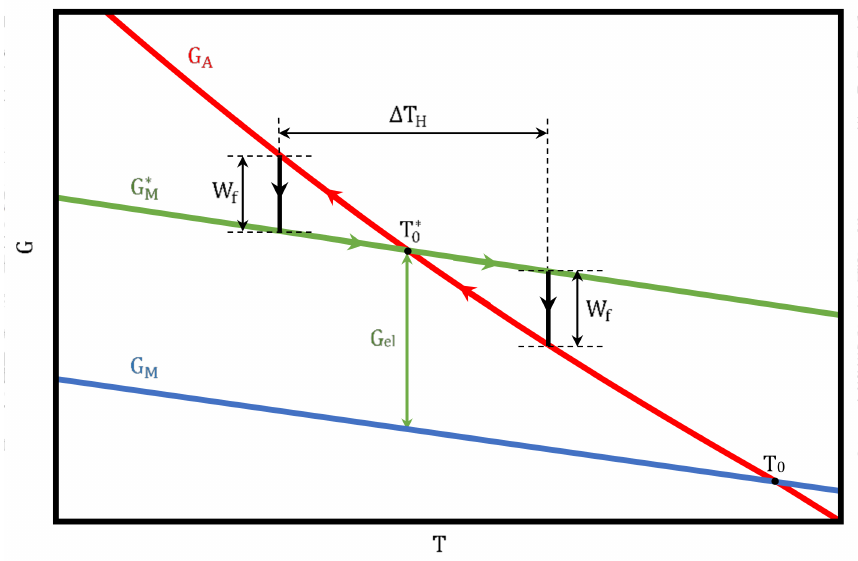
Figure 7. Schematic diagram of the Gibbs energy showing the transformation of a single variant at T ∗ . The Gibbs energy in the austenite phase G A in red, the one in the martensitic phase G M in blue, 0 the effective Gibbs energy G ∗ in green. The associated elastic energy G el and the thermal hysteresis M ∆ T H related to the “frictional work” ( W f ) are also